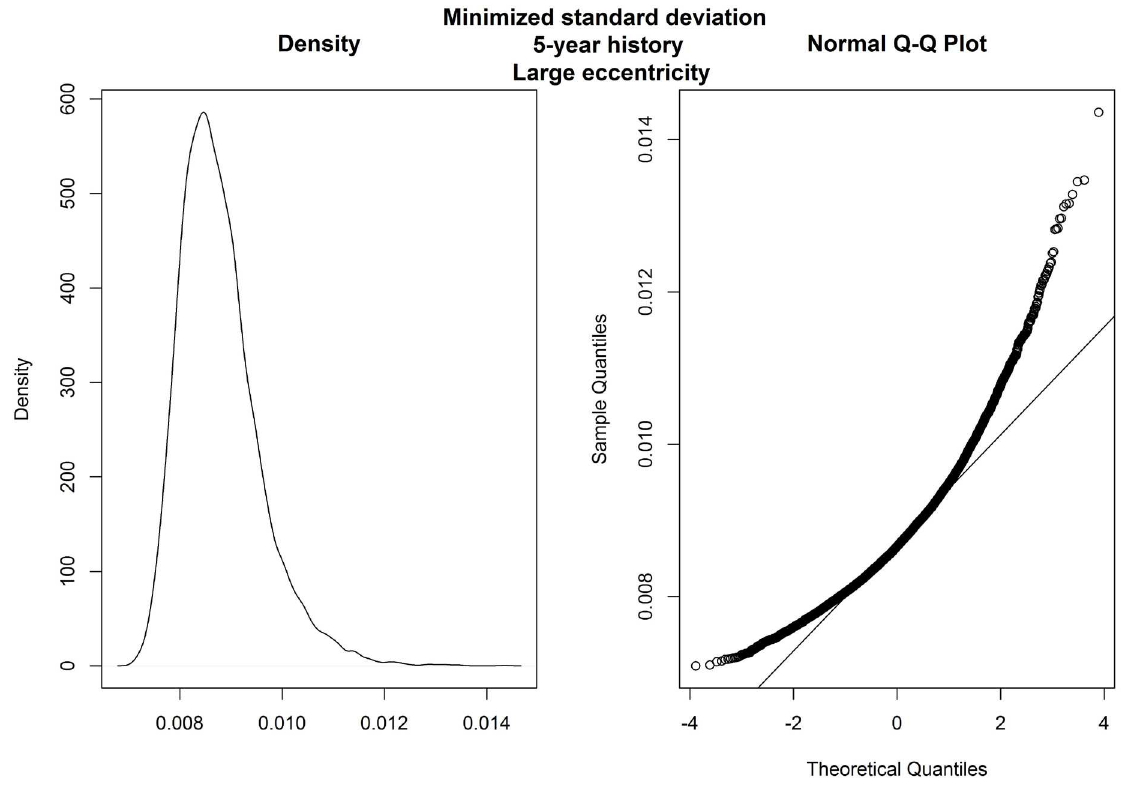
Figure 3. Density and normal Q-Q plot of minimized standard deviation of the